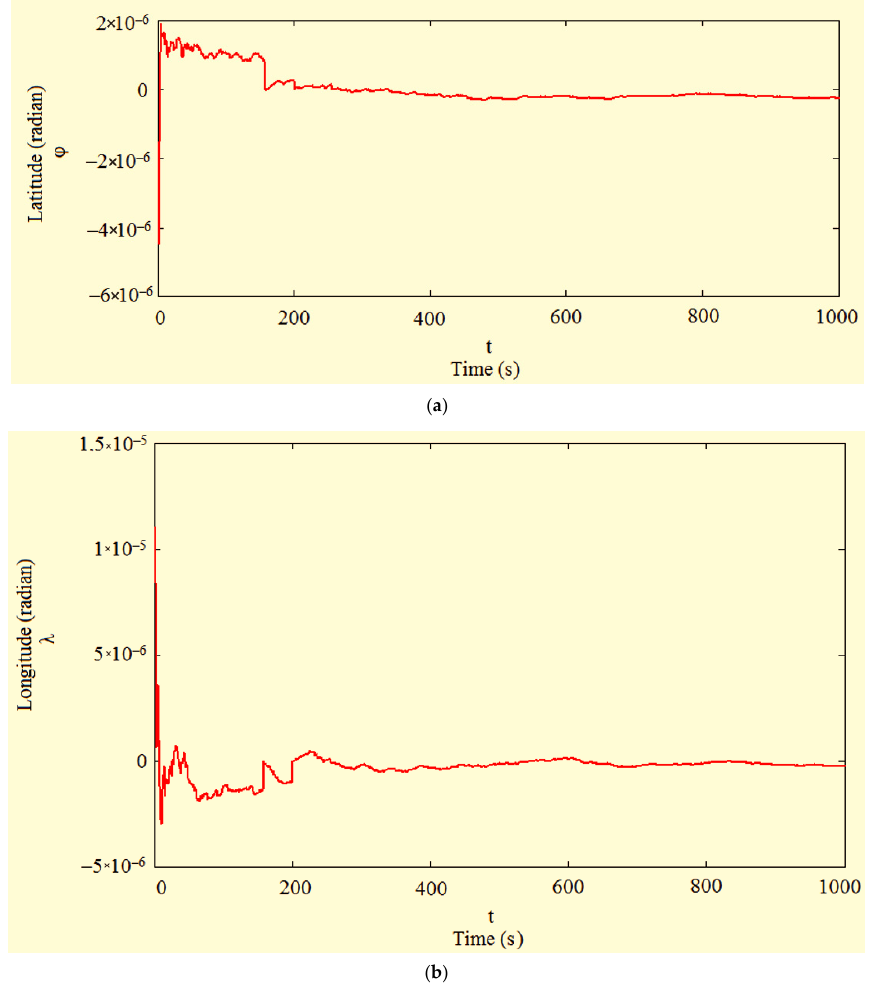
Figure 2. Graphs of latitude φ ( a ) and longitude λ ( b ) estimation errors obtained when implementing the adaptive filter.